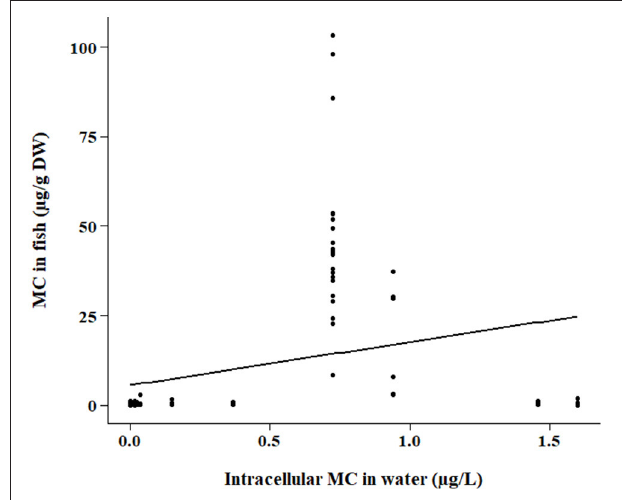
FIGURE 3 | Same as Figure 2 except samples were quantified by the PP2A method.